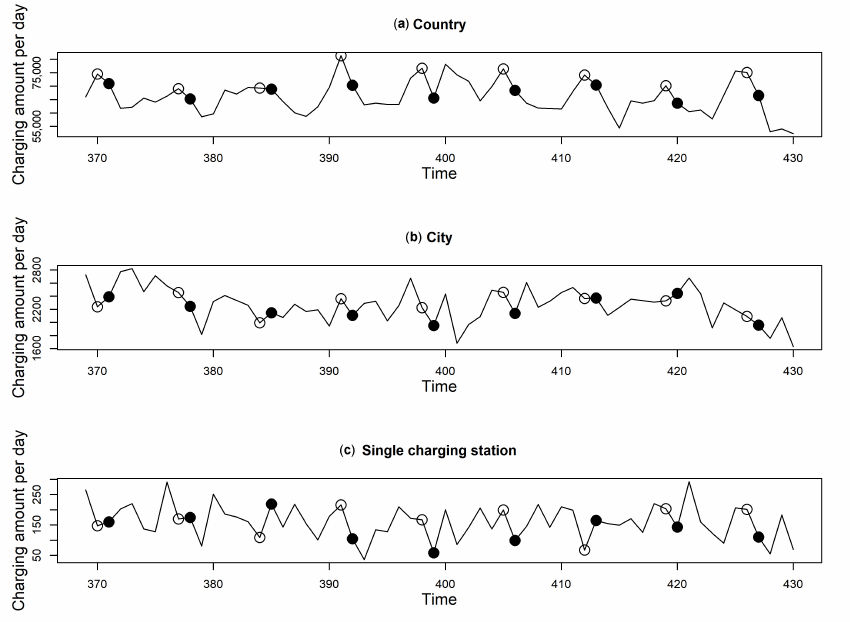
Figure 2. EV charging amount patterns in different seasons at three geographical scales: ( a ) country, ( b ) city, and ( c ) single charging station. White dots represent Saturdays, and black dots represent Sundays. The y -axis presents the daily energy used (unit: kW/day). The x -axis presents the periods of two weeks in